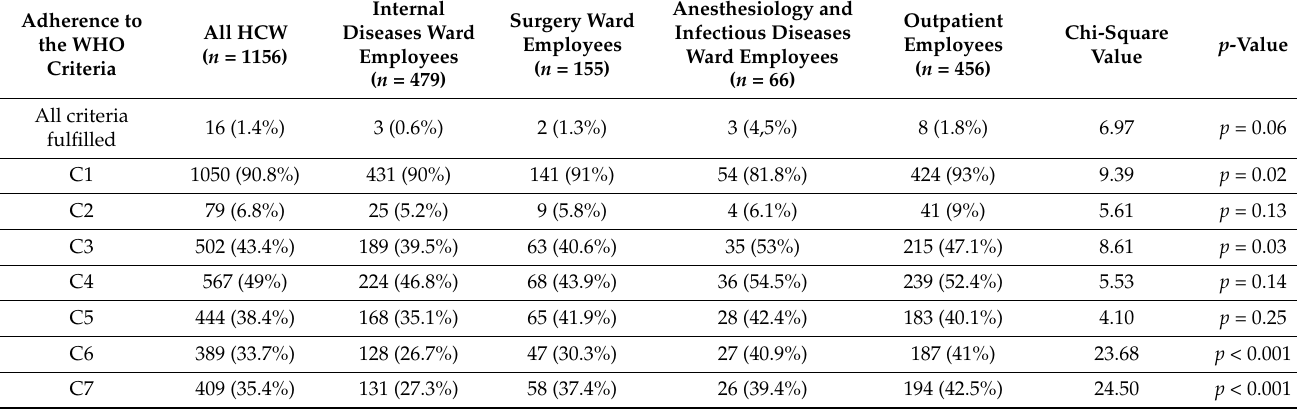
Table 4. Adherence to the WHO criteria among HCW working in different medical departments.